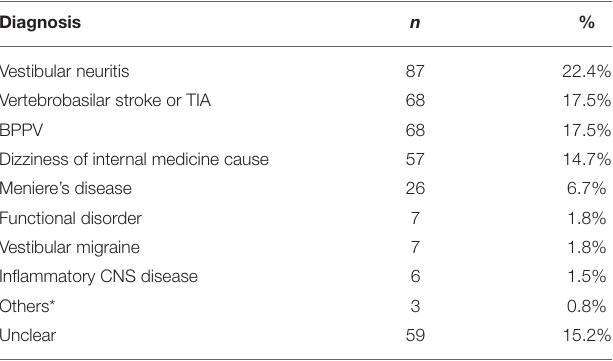
TABLE 3 | Distribution of hospital discharge diagnoses of all cases ( n = 388) with an acute leading symptom of dizziness, vertigo, or imbalance of unknown cause